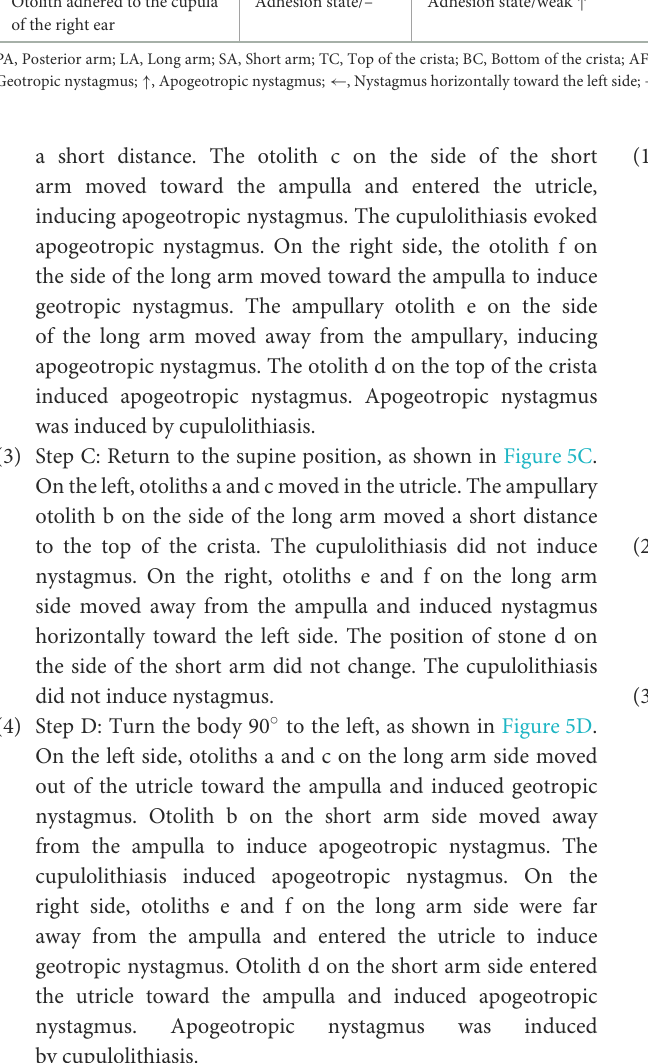
Movement in the utricle or out of the utricle to the ampulla/– or strong